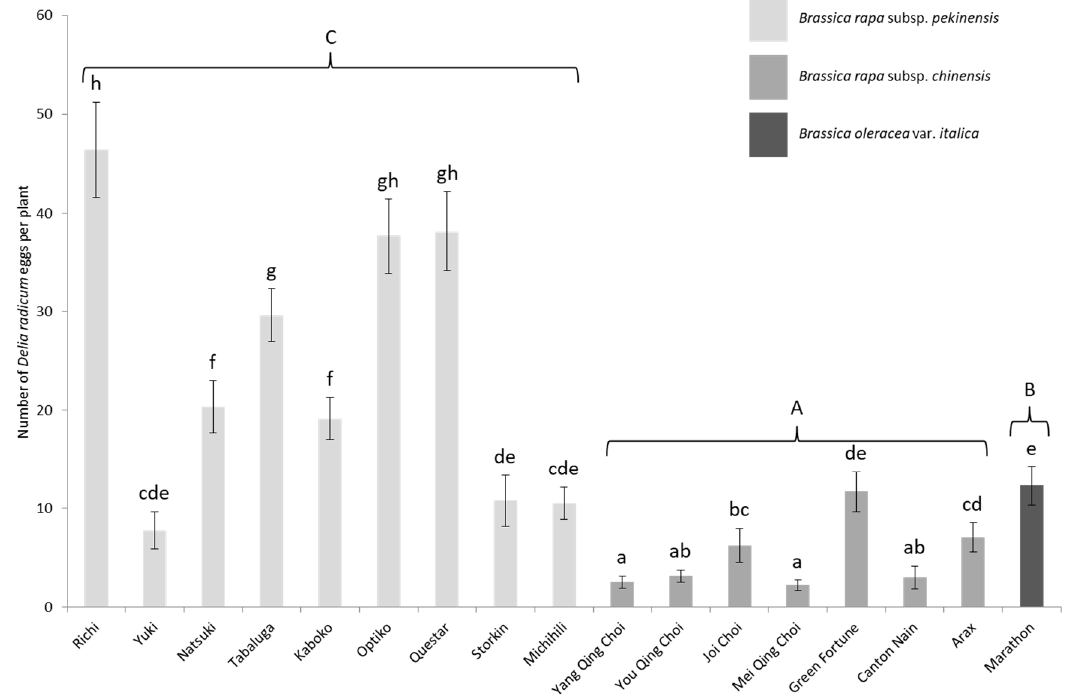
Figure 2. Mean number ( ± S.E.) of D. radicum eggs per plant depending on the cultivar in the laboratory experiment. Di ff erent capitalized letters indicate significant di ff erences between subspecies (GLMM, FDR, p < 0.05) and lowercase letters, significant di ff erences between cultivars (GLMM, FDR, p <